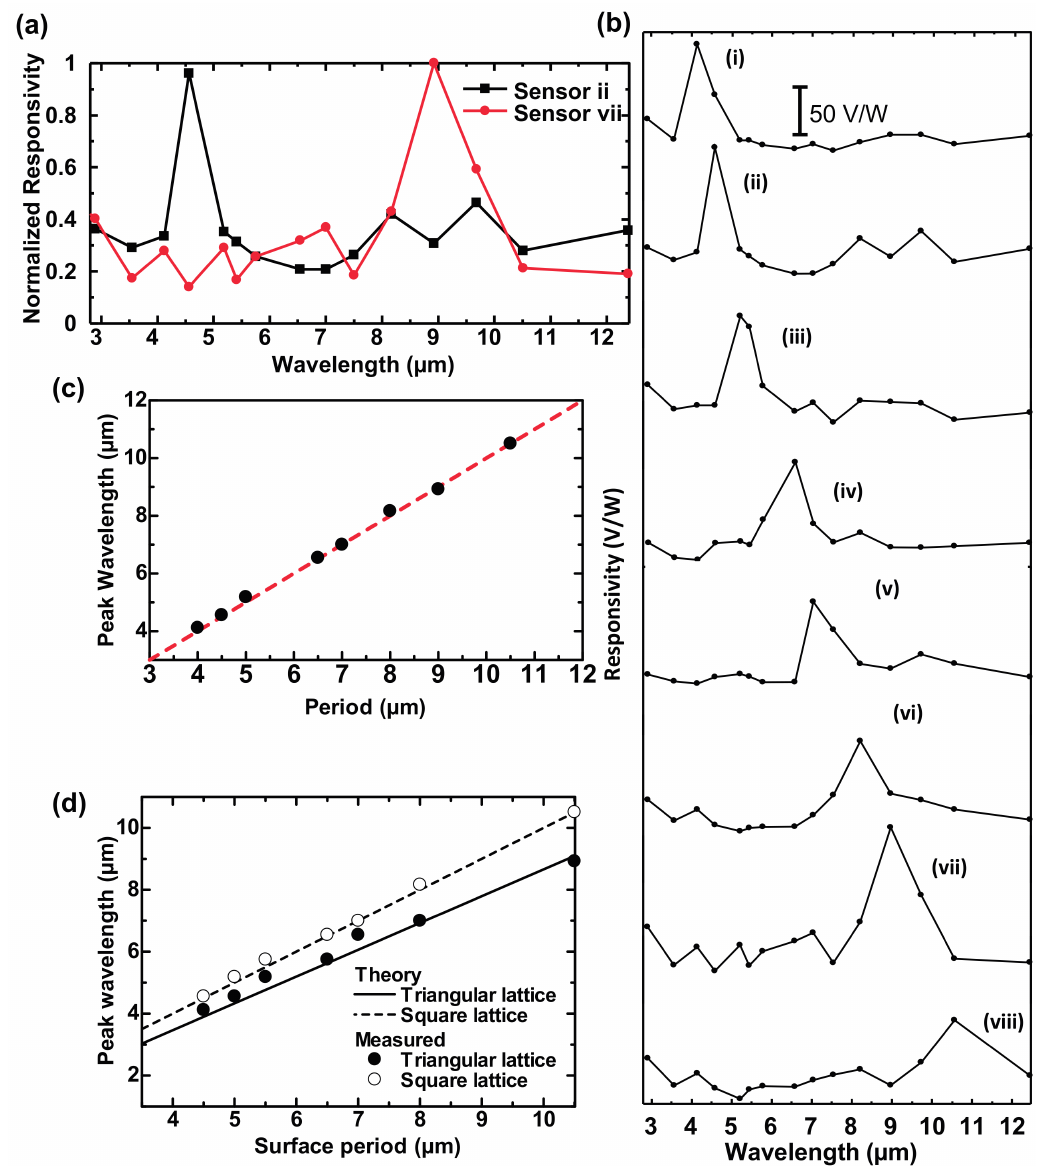
Figure 5. Measured spectral responsivity of developed sensors ( a ) (ii) and (vii); and ( b ) (i) to (viii); ( c ) Peak wavelength of the responsivity as a function of surface period for 2D-PA with square lattice; ( d ) Comparison of peak responsivity vs. surface period for 2D-PA square and triangular lattices. Two-color image sensors were then fabricated [97]. Figure 7a shows an optical image of the fabricated 50 µ m-pixel-pitch 320 × 240 SOI diode IRFPA with TH MIM-PMAs, which has dimensions of 20.0 × 19.0 mm 2 . Figure 7b,c show SEM images of MIM-PMAs for the left and right halves of the 320 × 240 pixel array, which detect wavelengths of 4.7 and 7.6 µ m, respectively. Figure 7e shows the image of the light emitter as shown in Figure 7d taken by the developed sensor. The light emitter was attached with a narrow bandpass filter with a center wavelength of 4.7 µ m, which corresponds to the absorption wavelength of the left half of the pixel